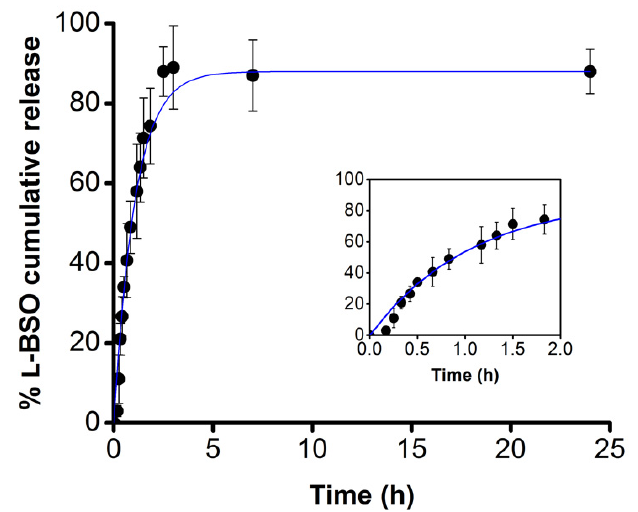
Figure 3. In vitro release profile of L -buthionine-( R,S )-sulfoximine ( L -BSO) encapsulated in a PURE G4 -FA 2 dendrimer ( L -BSO@PURE G4 -FA 2 ) nanoformulation at pH 7.4. The inset shows L -BSO cumulative release in the first two hours.